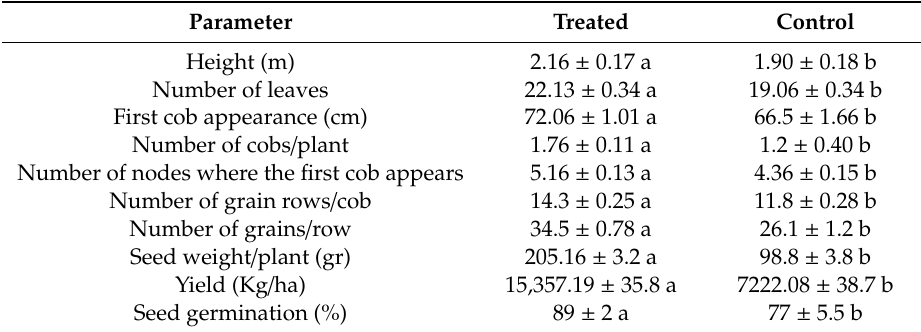
Table 1. Growth parameters, yield characteristics, and seed germination from corn plants colonized with Beauveria bassiana (LPSc 1098) (treated) and non-colonized corn plants (control). Mean values ± SEM presented. Within each parameter measured (row) numbers followed by different letters are significantly different (Student's t -test).